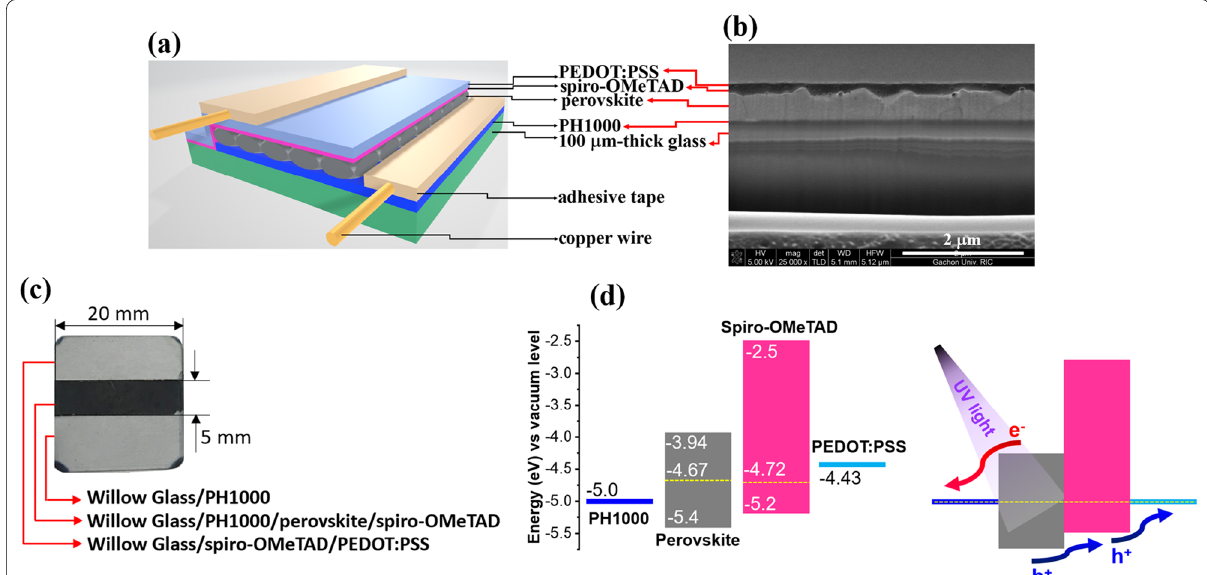
Fig. 2 a Schematic diagram of the device; b Cross-sectional image of the device; c Photograph of the corresponding device; and d Energy diagram illustrating the charge carrier transport in the halide perovskite photodetector under UV light